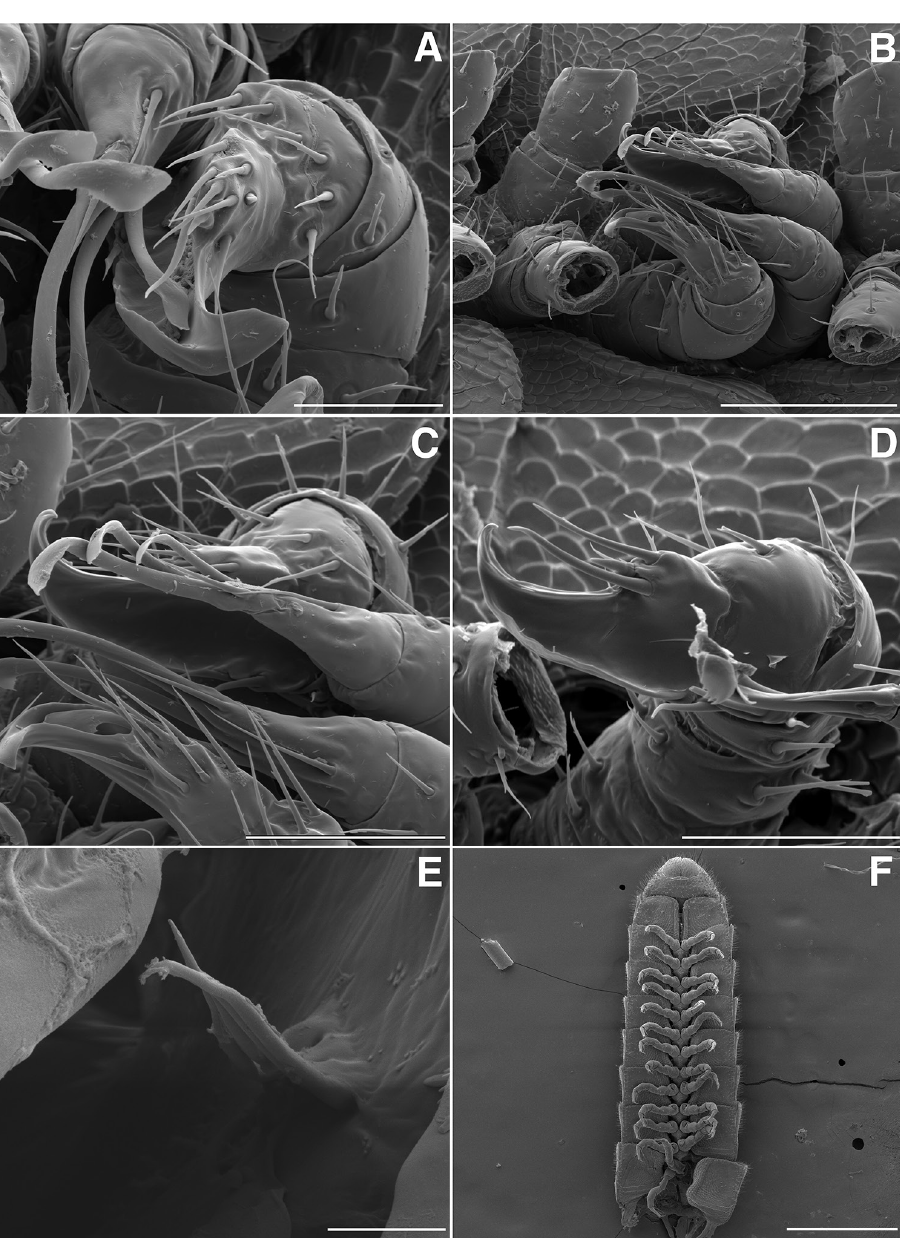
Figure 19. Illacme tobini sp. n.: A anteroventral view of left gonopod in situ (scale bar 30 µm) B vent- rolateral (right) view of gonopods in situ (leg pairs 7, 8, 11 broken off at prefemur-femur joint) (scale bar 100 µm) C Medial view of right anterior gonopod of I. tobini sp. n. (scale bar 50 µm) D the same of I. plenipes (scale bar 50 µm). Illacme tobini sp. n.: E anterodorsal view of head with mouth open showing dorsal surface of left gnathochilarial stipe with unidentified brush-like structure (scale bar 5 µm) F ventral view of posterior rings (scale bar 500 µm). (Catalog #s: I. tobini sp. n. MPE00735, I. plenipes